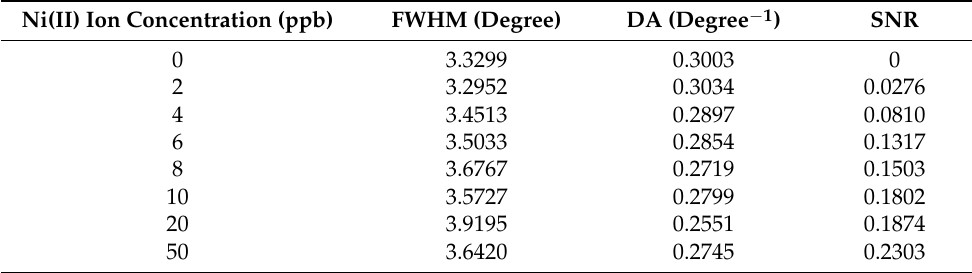
Figure 7. Signal-to-noise-ratio of Au/MPA/V–CNCs–CTA thin film when detecting Ni(II) ion solution ranged from 2 ppb to 50 ppb. Table 4. Full width at half maximum (FWHM), detection accuracy (DA), and SNR of Au/MPA/V– CNCs–CTA thin film with respect to Ni(II) ion